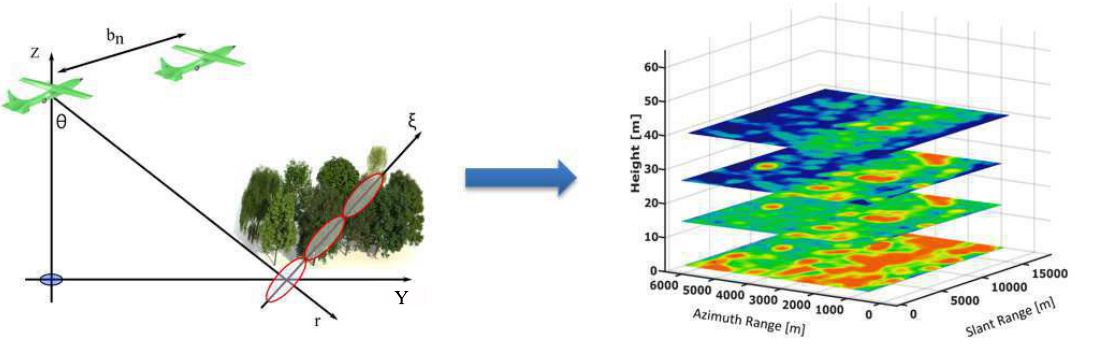
Figure 2. Left Schematic representation of the tomographic SAR (TomoSAR) acquisition. The azimuth axis is orthogonal to the picture. Right Schematic view of TomoSAR imaging, where each layer represents the scattering contributions associated with a certain